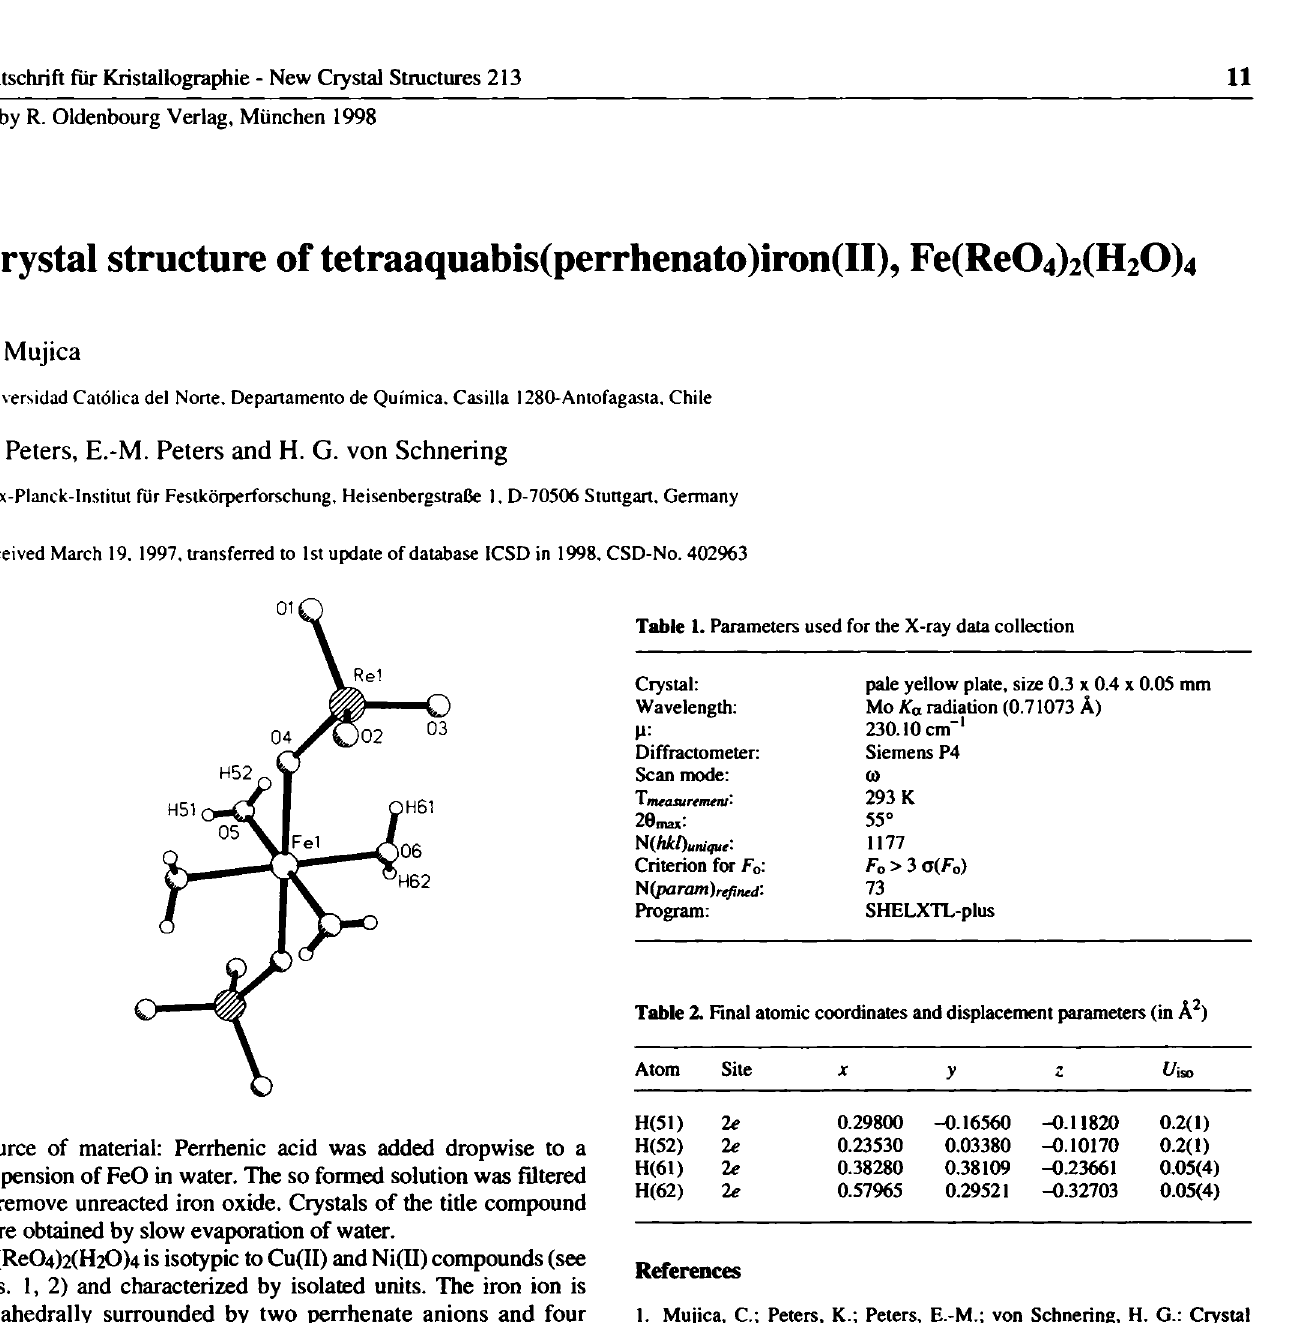
Table 2. Final atomic coordinates and displacement parameters (in